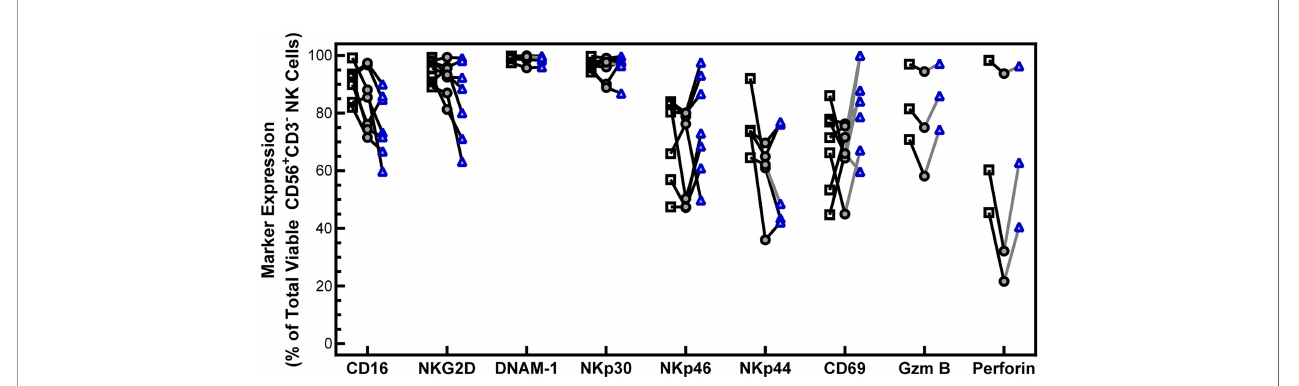
FIGURE 2 | NK cells maintain the expression of activating receptors after cryopreservation. PM21-NK cells expanded from T-cell-depleted PBMCs were obtained from multiple donors (N = 3 – 7). Cells were cryopreserved while donor-matched fresh PM21-NK cells (black squares) were maintained in culture. Frozen PM21-NK cells were thawed and rested 16 h the day before analysis (blue triangles) or thawed and rested for 1 h on the day of analysis (gray circles). Expression of NK cell activating receptors CD16, NKG2D, DNAM-1, NKp30, NKp46, NKp44, as well as CD69, granzyme B, and perforin was determined by fl ow cytometry. No statistically signi fi cant difference was seen in the expression of activating receptors either 1 h immediately post-thaw or after a 16-h rest in donor and expansion- matched PM21-NK cells (N = 5 – 7 donors). Data are presented as a scatter plot with each point representing the average of two technical replicates with donor-pair lines. No statistical signi fi cance was determined by multiple paired t-tests with a threshold for signi fi cance at p <